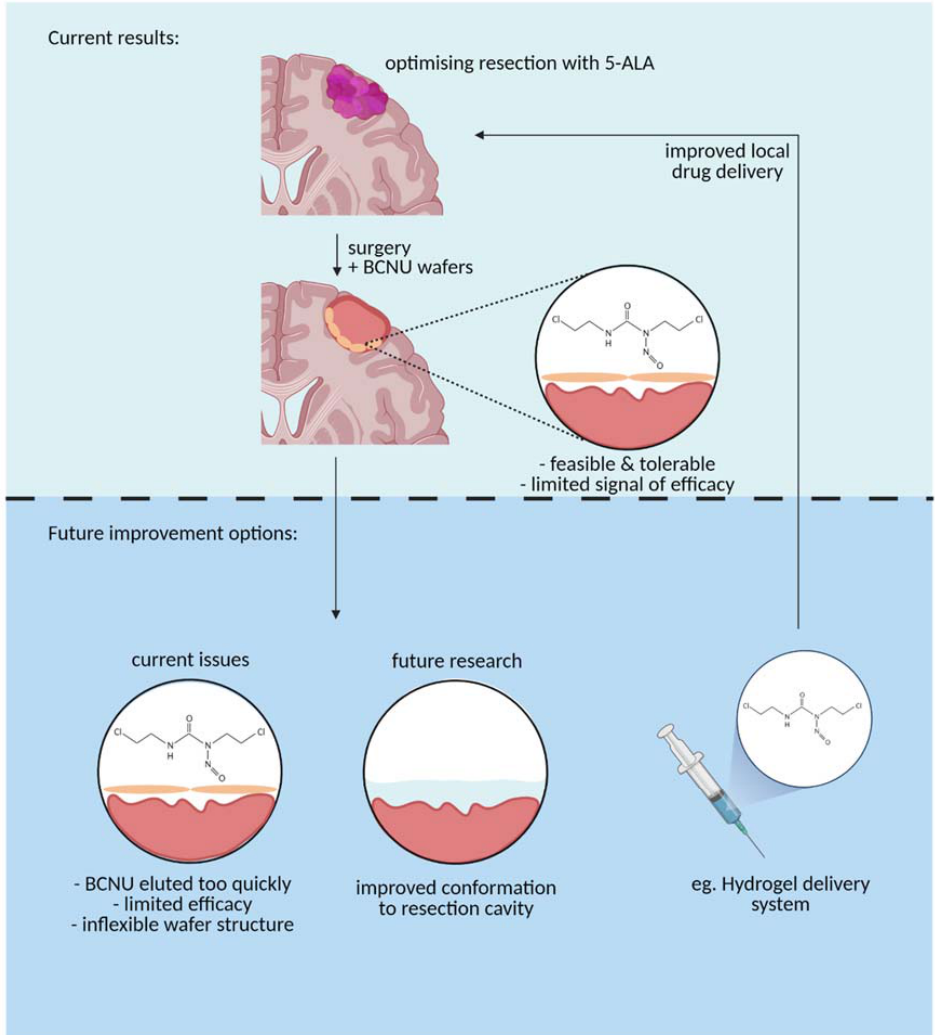
Figure 5. A graphical representation of the current BCNU drug delivery mechanism (top panel) vs. future improvements to the delivery mechanism to optimize use (bottom panel) (Created with BioRender.com, accessed on 13 April 2021).